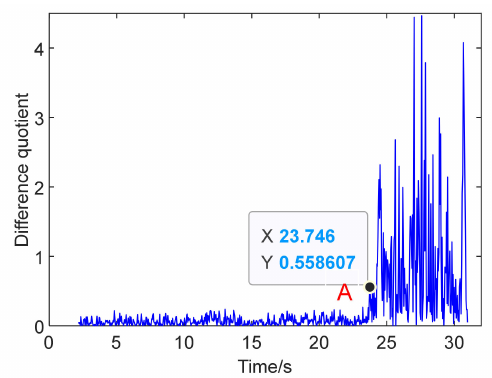
Figure 16. Difference quotient of the dynamic G-SampEn in multi-step